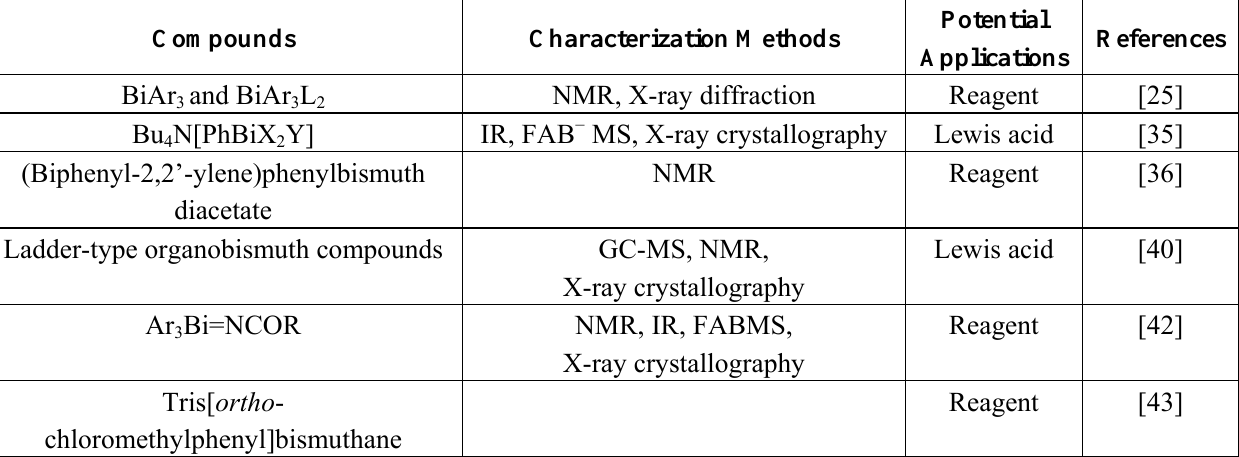
Table 1. Various types of traditional and novel organobismuth